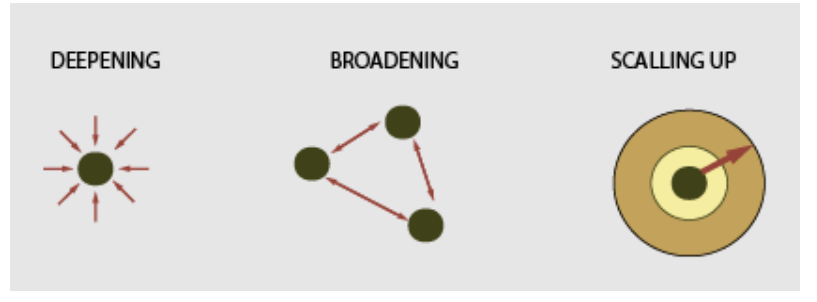
Figure 4. Deepening, Broadening, and Scaling-up in the Transition Experiments in relation to a multilevel perspective. Elaborated by the